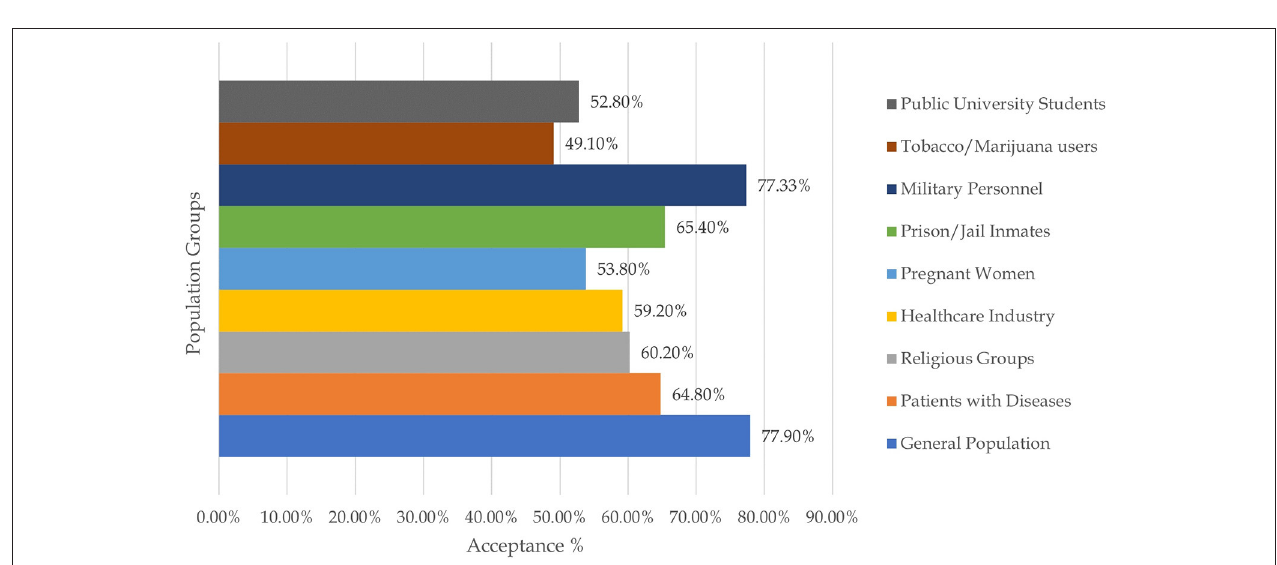
FIGURE 2 | COVID-19 vaccine acceptance rates of United States.